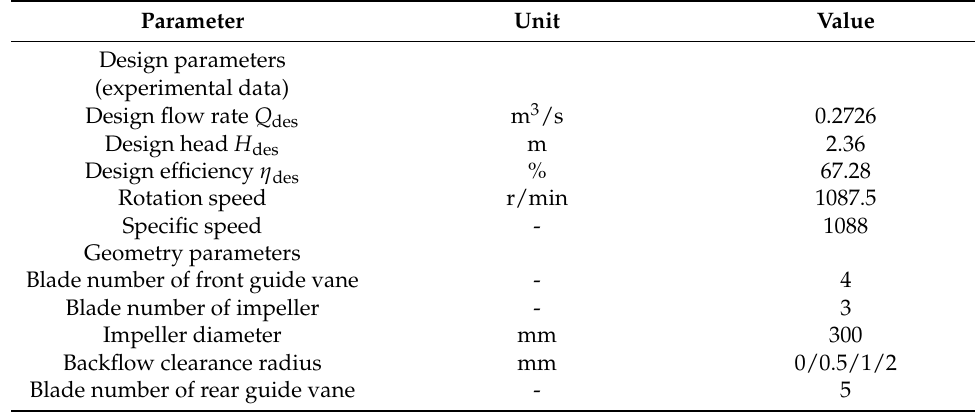
Table 1. Main parameters of full tubular pump